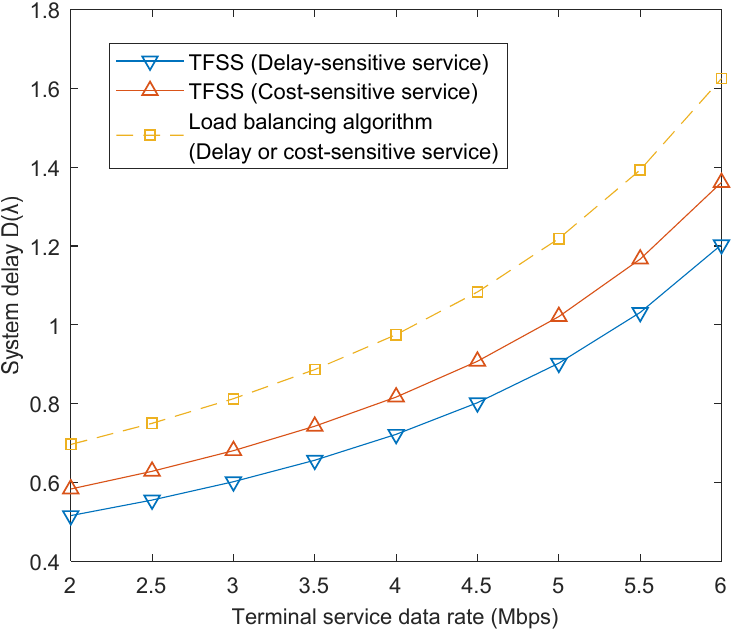
Figure 5. System delay comparison results.